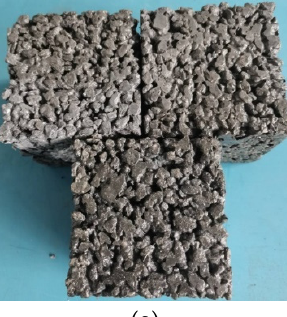
20 days, the aggregate did not fall off, and a white colloid appeared, almost filling the surface gap of the specimen; when the corrosion time lasted for 40 days, the aggregate was obviously exposed and fell off slightly, the white colloid gradually disappeared, and the soaking solution became turbid; when the corrosion time was 60 days, the surface of the an uneven shape due to the aggregate falling off (at the corners of the specimens).